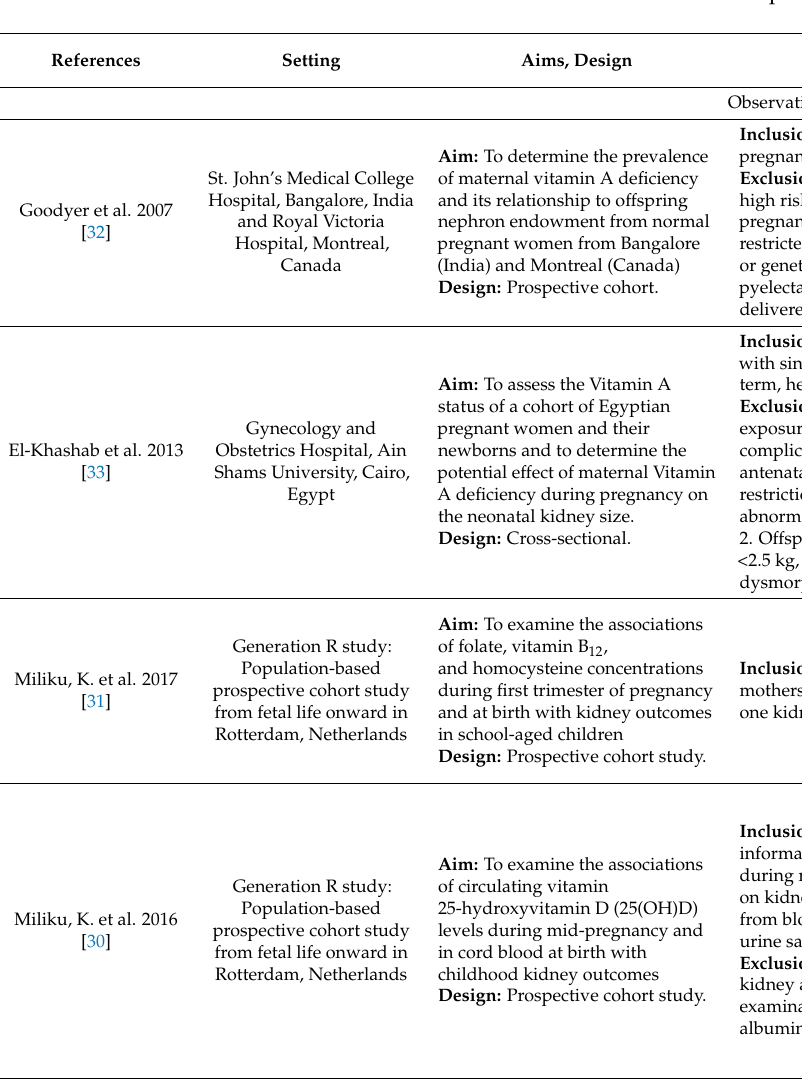
Table 2. Description of observational